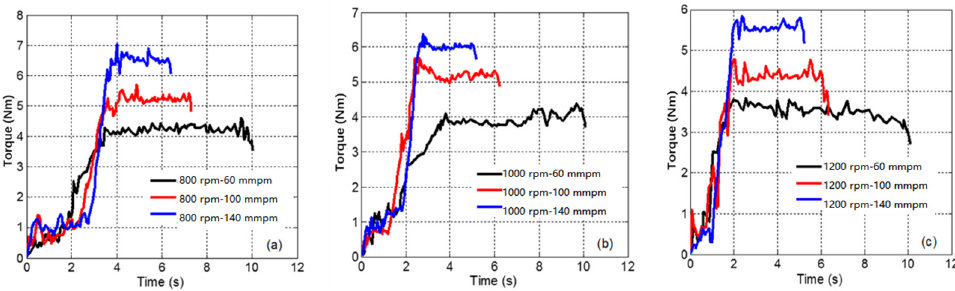
Figure 6. Spindle torque differences at different feed rates. ( a ) 800 rpm; ( b ) 1000 rpm; ( c ) 1200 rpm.